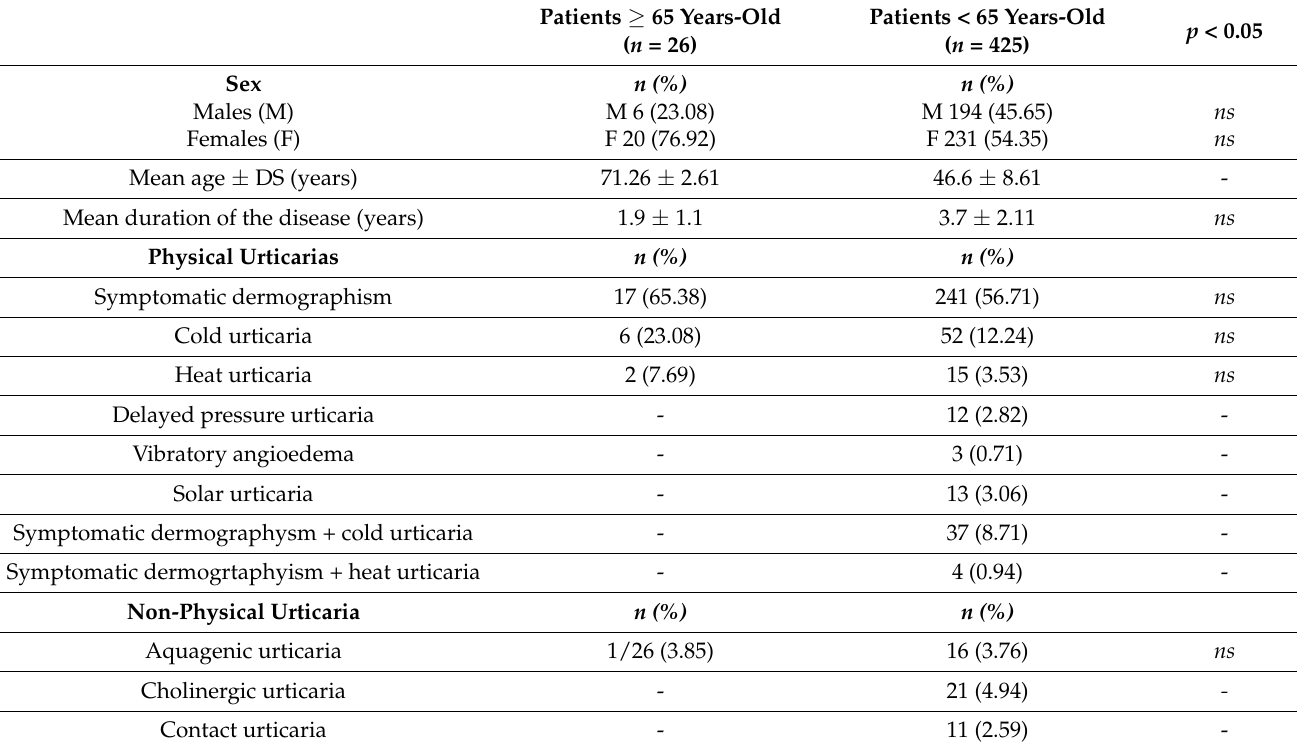
Table 3. Main features of patients with CIndUs ≥ 65 years ( n = 26) and <65 years of age ( n = 425).